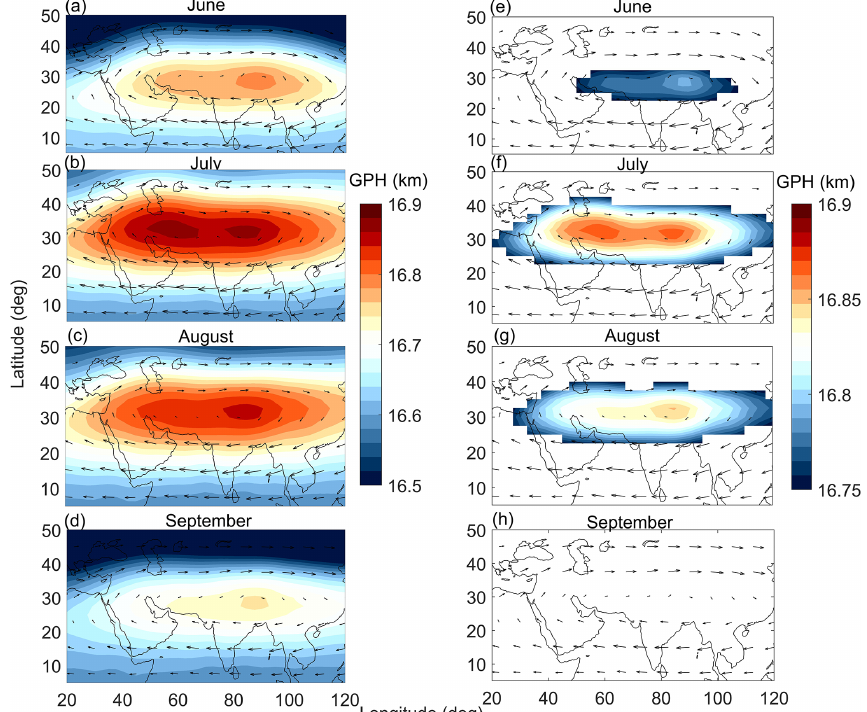
Figure 1. Spatial distribution of geopotential height (GPH) and wind vectors at 100hPa during (a) June, (b) July, (c) August and (d) Septem- ber from NCEP reanalysis data averaged from 1951 to 2016. The core of the anticyclone region was chosen based on the GPH values ranging from 16.75 to 16.9km. The spatial extent and magnitude of the anticyclone after applying the GPH criteria for (e) June, (f) July, (g) August and (h)